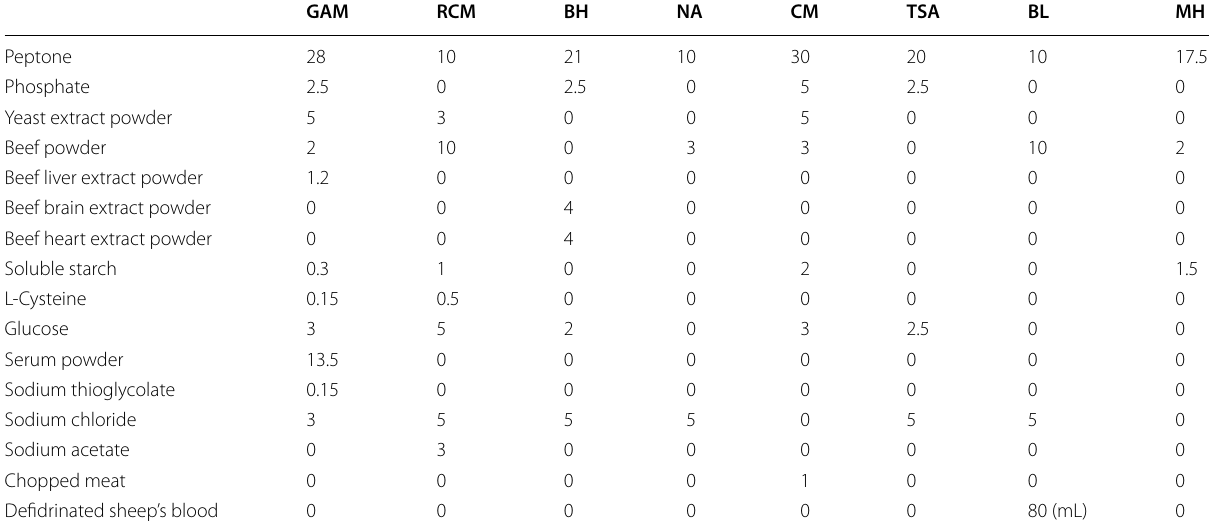
Table 1 The composition of each medium